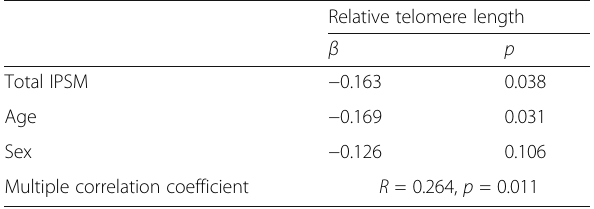
Table 2 Effects of the total IPSM scores, age, and sex on relative telomere length